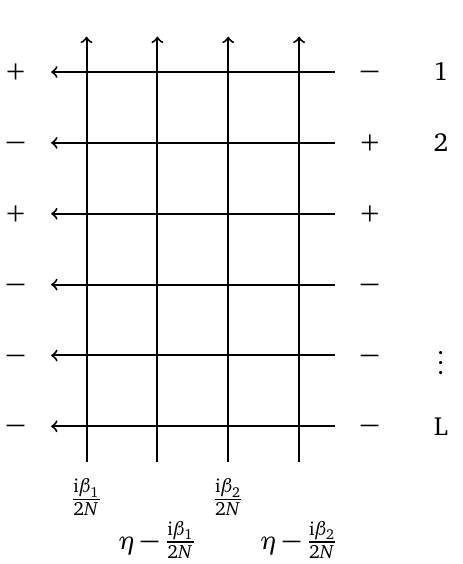
Figure 3: An example for the partition function (4.10) after the reflection along the North-West diagonal. The horizontal lines are now interpreted as the matrix ele- ments of T . We have periodic boundary conditions in the vertical direction, which QTM amounts to taking the trace of a certain product of A , B , C , D operators. In the present case we have Tr BCAD L − 2 .